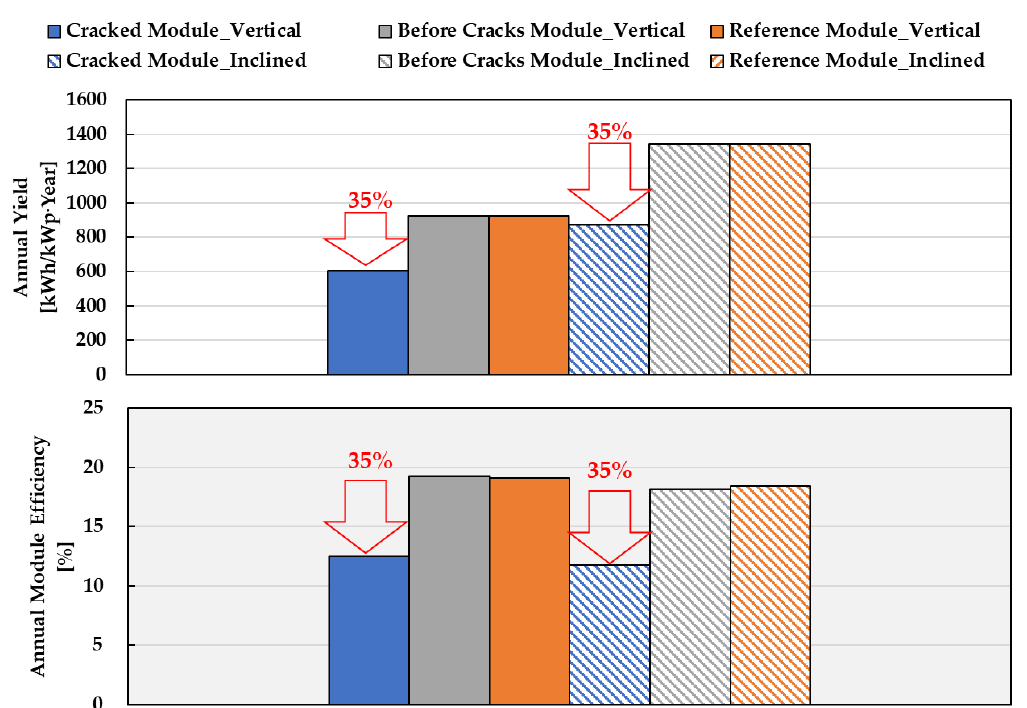
Figure 14. Comparison of annual module yields and efficiencies.